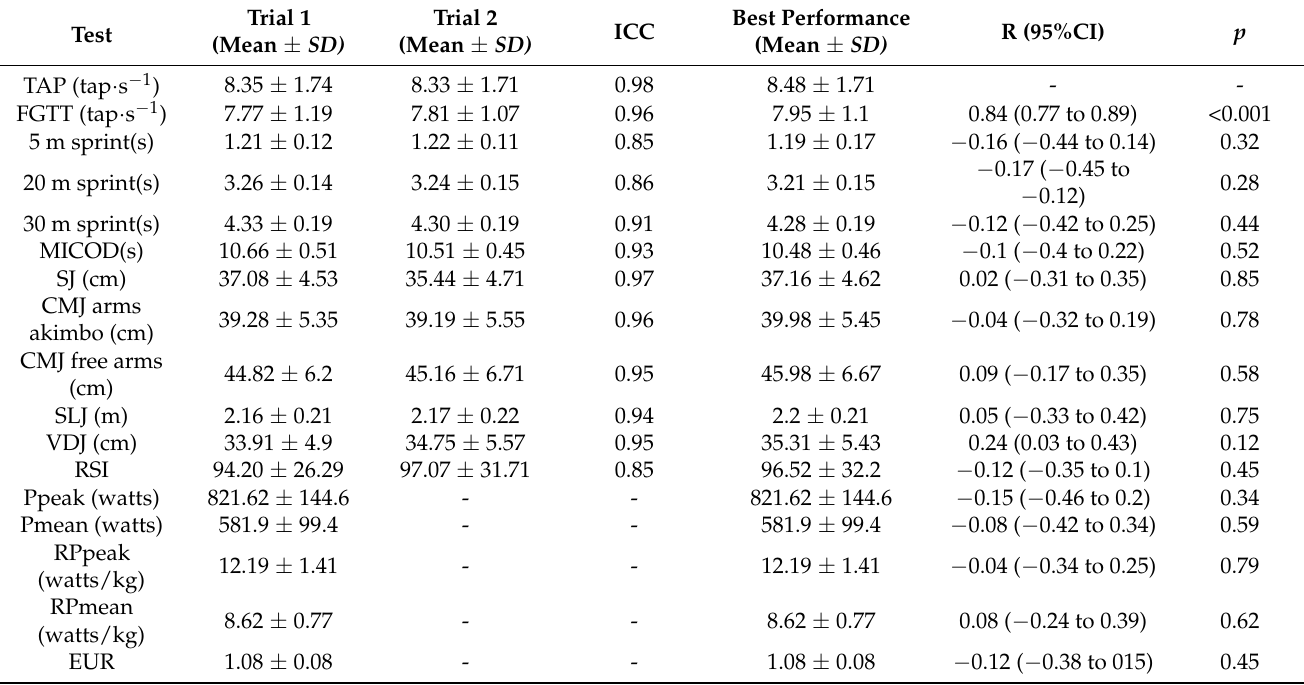
Table 3. Mean ± SD of players performances, Intraclass Correlation between trials 1 and 2 (ICC), correlation coefficient (r) between TAP test and other physical qualities and associated probability values ( p ).